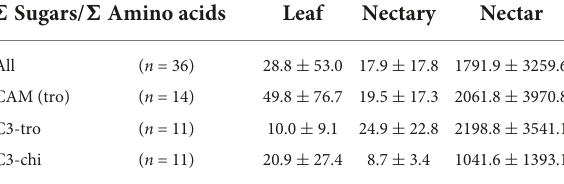
TABLE 1 The ratio of sum-of-sugars-to-sum-of-amino-acids in leaf, nectary and nectar divided according to photosynthesis and pollinator type.